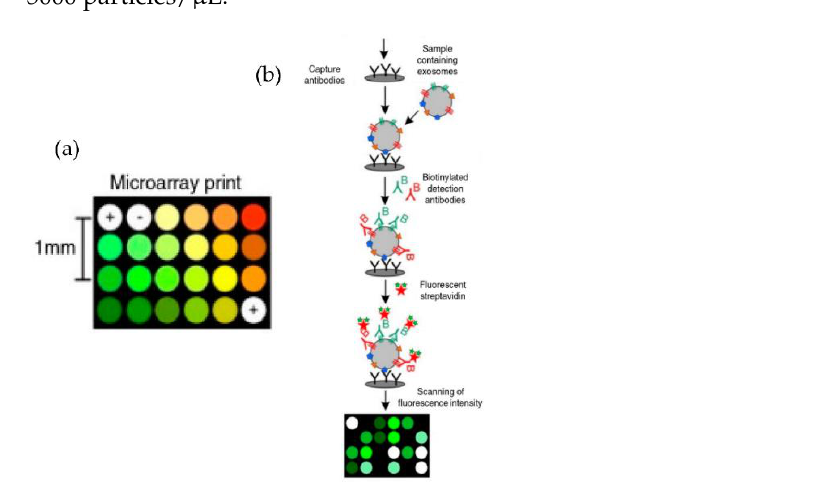
Figure 9. Extracellular vesicle detection using a customized protein microarray “ EV array .” ( a ) A microarray printed with spots of 21 different antibodies. ( b ) Workflow for capturing exosomes with biotinylated antibodies followed by fluorescence-labelled streptavidin. (Modified from Jorgensen et al. [73]. Copyright 2013, J Extracell